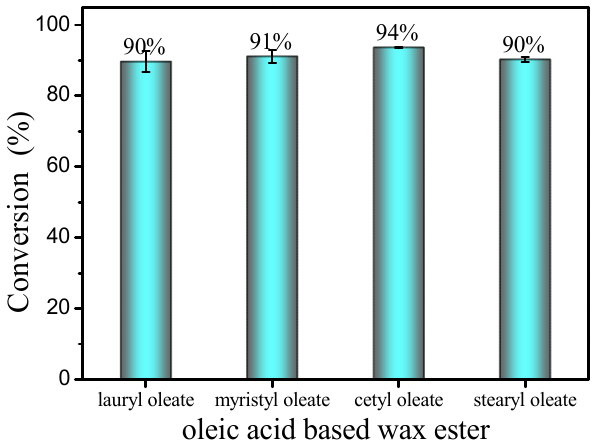
Figure 10. Esterification of oleic acid with different long-chain alcohols. Reaction conditions: a reaction temperature of 40 °C, 10 mol% DBSA, a molar ratio of 1.3:1 fatty acids to alcohol and a reaction time of 4 h.